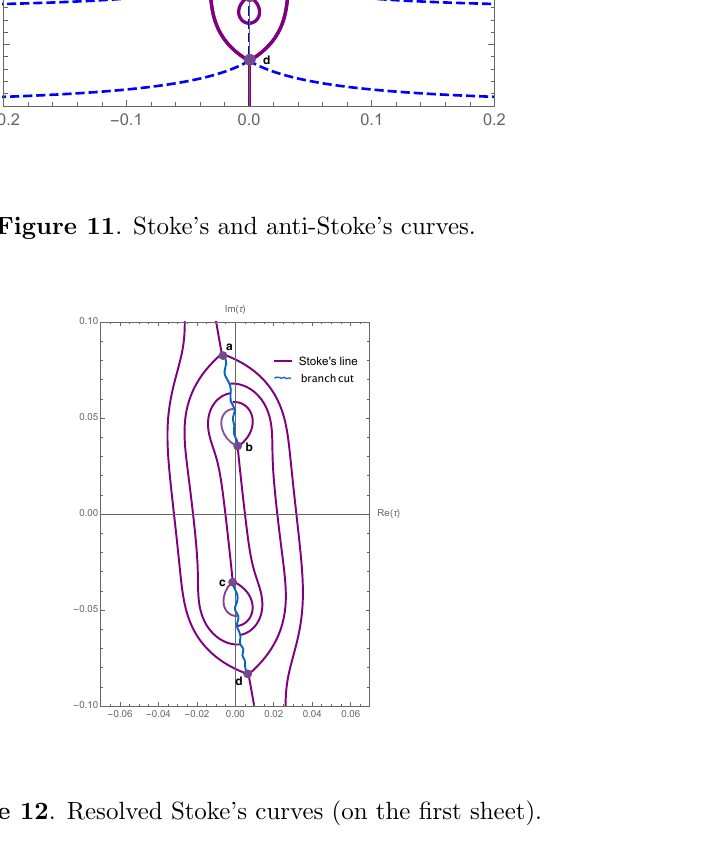
Figure 12 . Resolved Stoke’s curves (on the (cid:12)rst